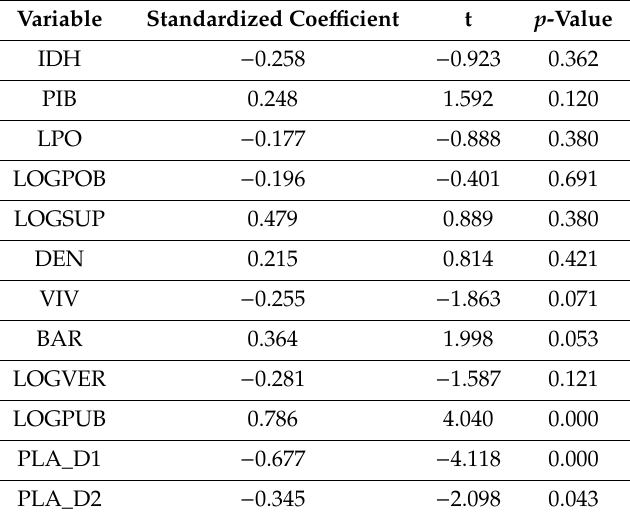
Table 3. p -Values of independent variables.